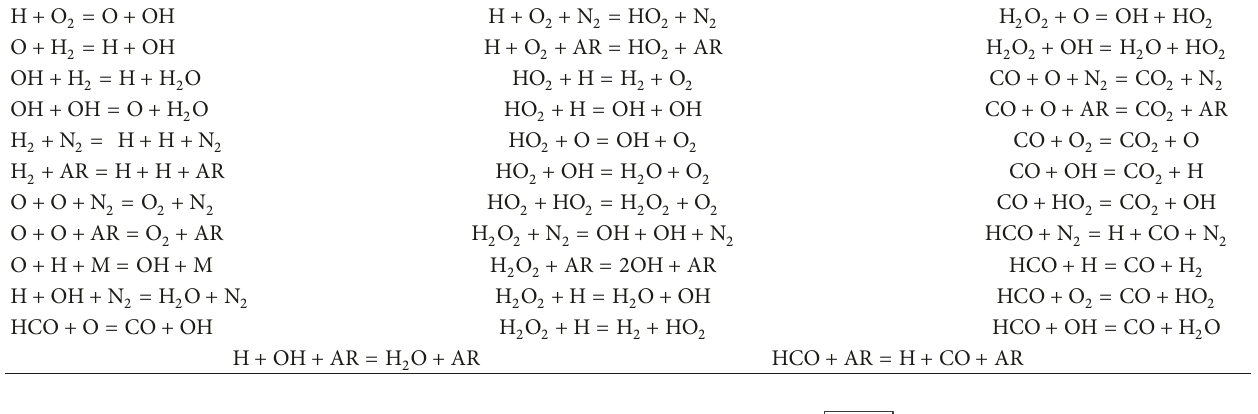
Table 2: Reactions of Yetter mechanism.